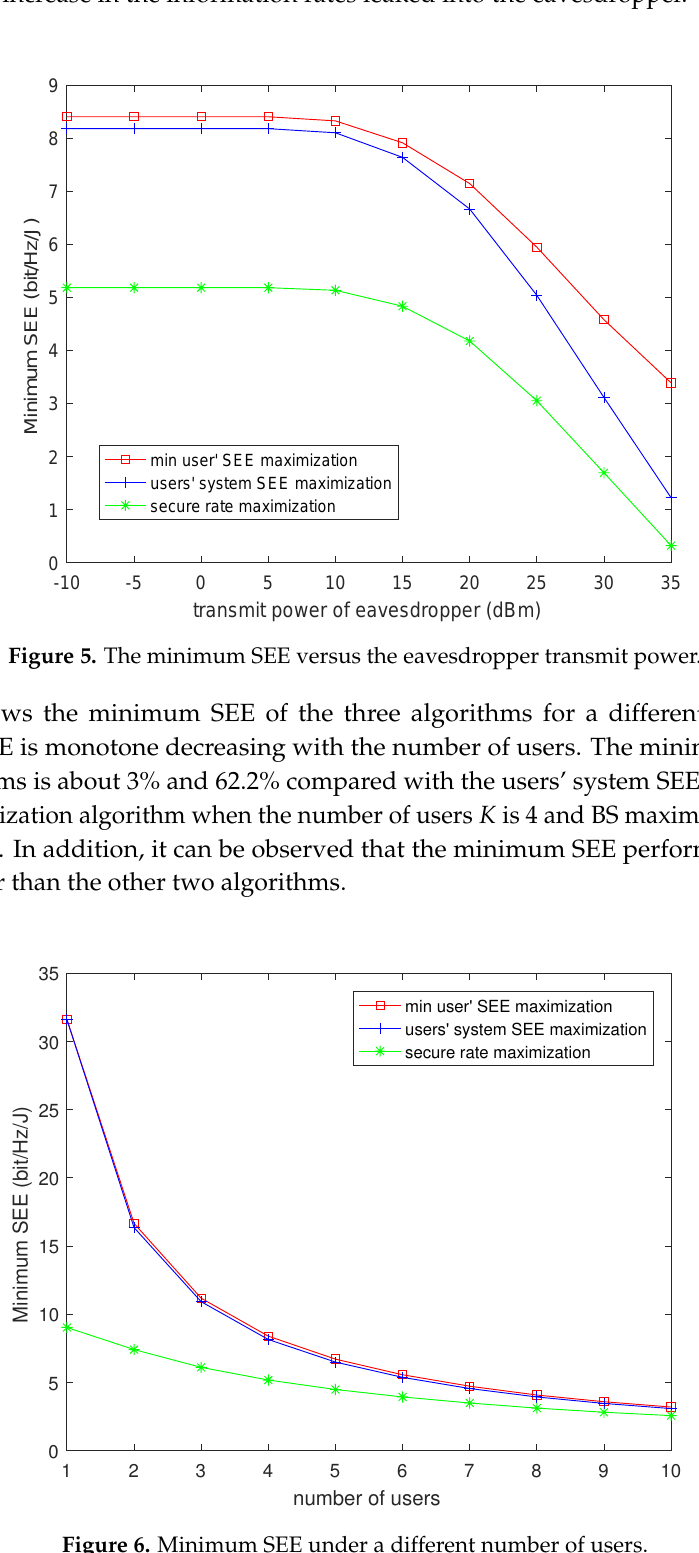
Figure 6. Minimum SEE under a different number of